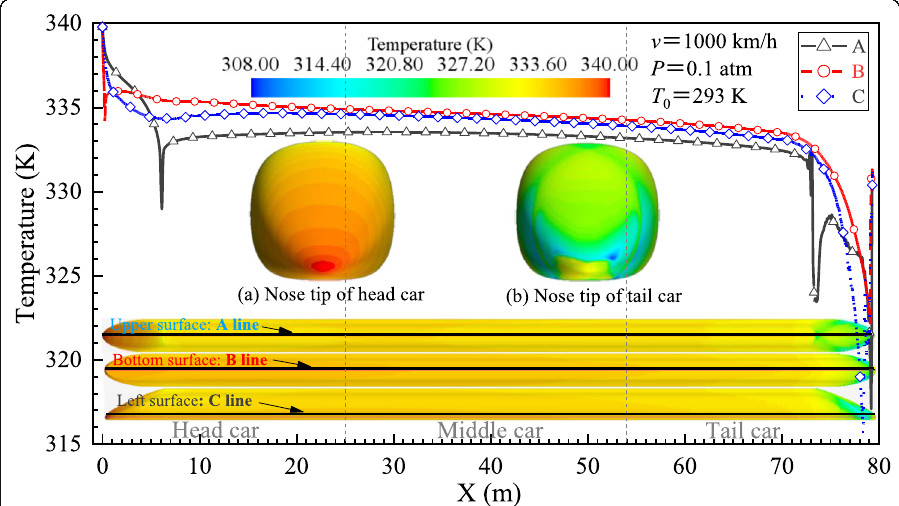
Fig. 9 Temperature distribution on train surface: line A and line B are the intersection lines between the upper and lower surface of the train and the xy plane, respectively; line C is the intersection line between the left surface of the train and the xz